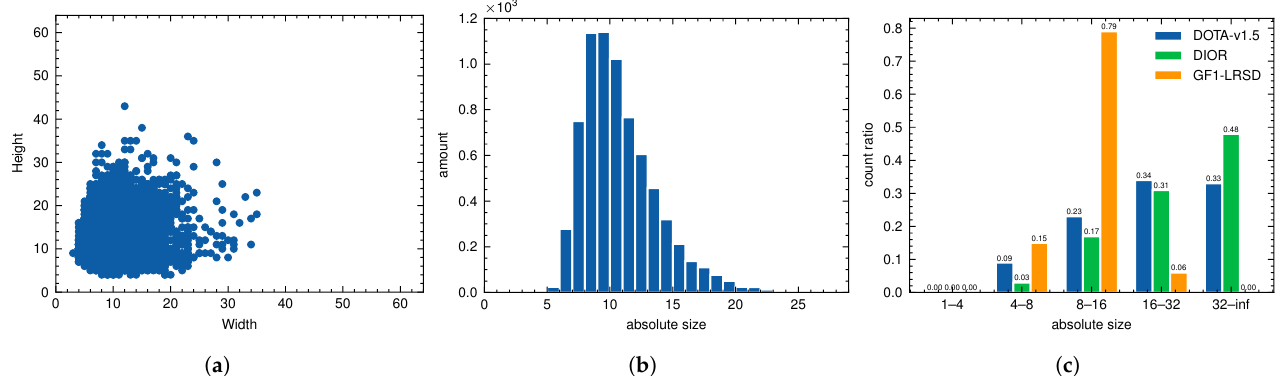
Figure 8. Statistics of instances in GF1-LRSD and other datasets. ( a ) Scatter plot of width and height distribution in GF1-LRSD. ( b ) Histgram of scale distribution in GF1-LRSD. ( c ) Comparison of scale distribution between GF1-LRSD and other